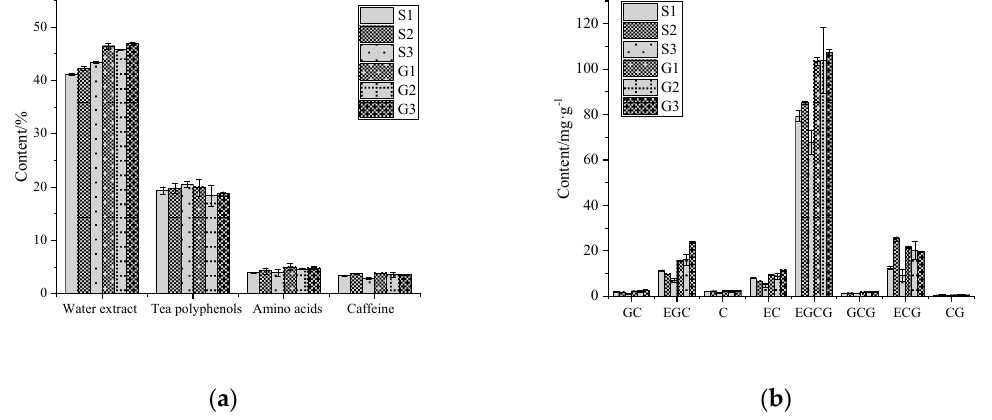
Figure 1. Histogram of mean chemical composition content in tea: ( a ) the average chemical content of each grade of tea and ( b ) the average catechin monomer content of each grade of tea. ECG: epicatechin gallate, EGCG: epigallocatechin gallate, GC: gallocatechin, EGC: epigallocatechin, C: catechin, EC: epicatechin, GCG: gallocatechin gallate, CG: catechin gallate.